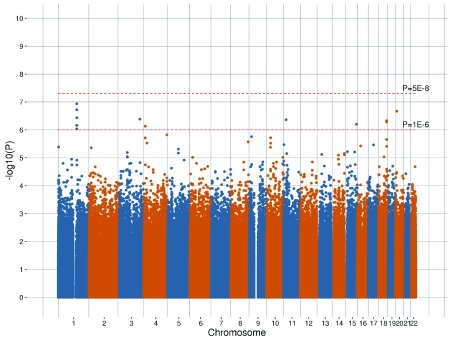
Manhattan plot representing the –log
10
P-values for an association between each assessed haplotype and cognitive score in the Generation Scotland: Scottish Family Health Study cohort study.